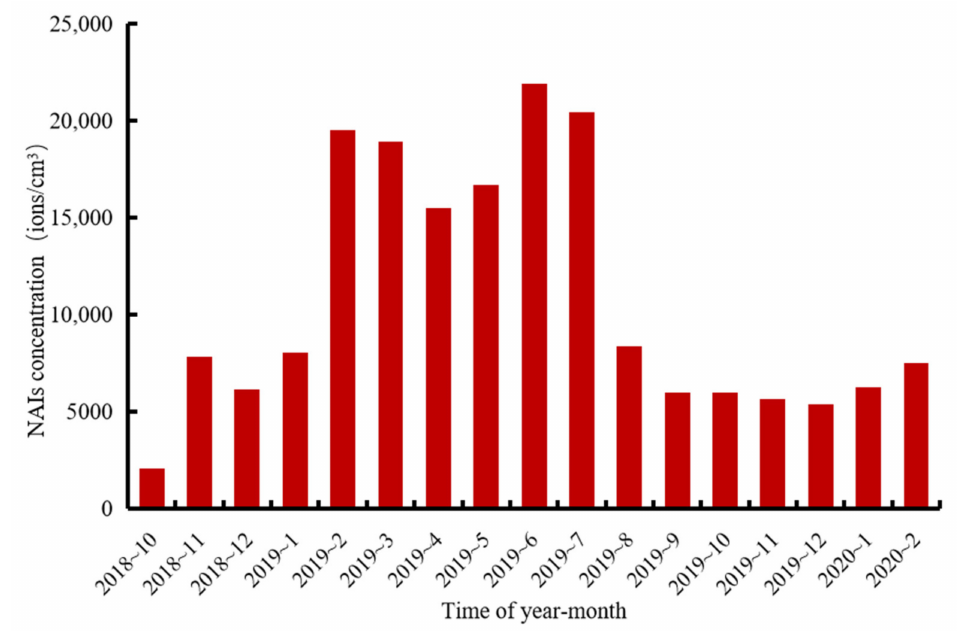
Figure 4. Monthly average NAI concentrations from October 2018 to February